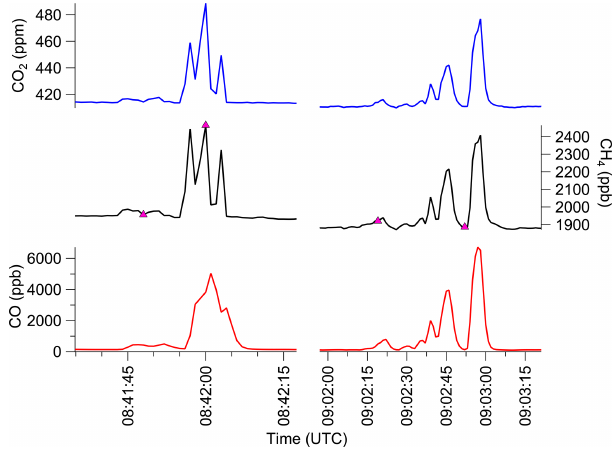
Figure 6. Time series of CO (red), CH 4 (black), CO 2 (blue), and concentrations in the plumes analysed for flight C005. Median WAS canister fill times are marked on the CH 4 time series as pink trian- gles. Note that some WASs taken in background regions are not shown